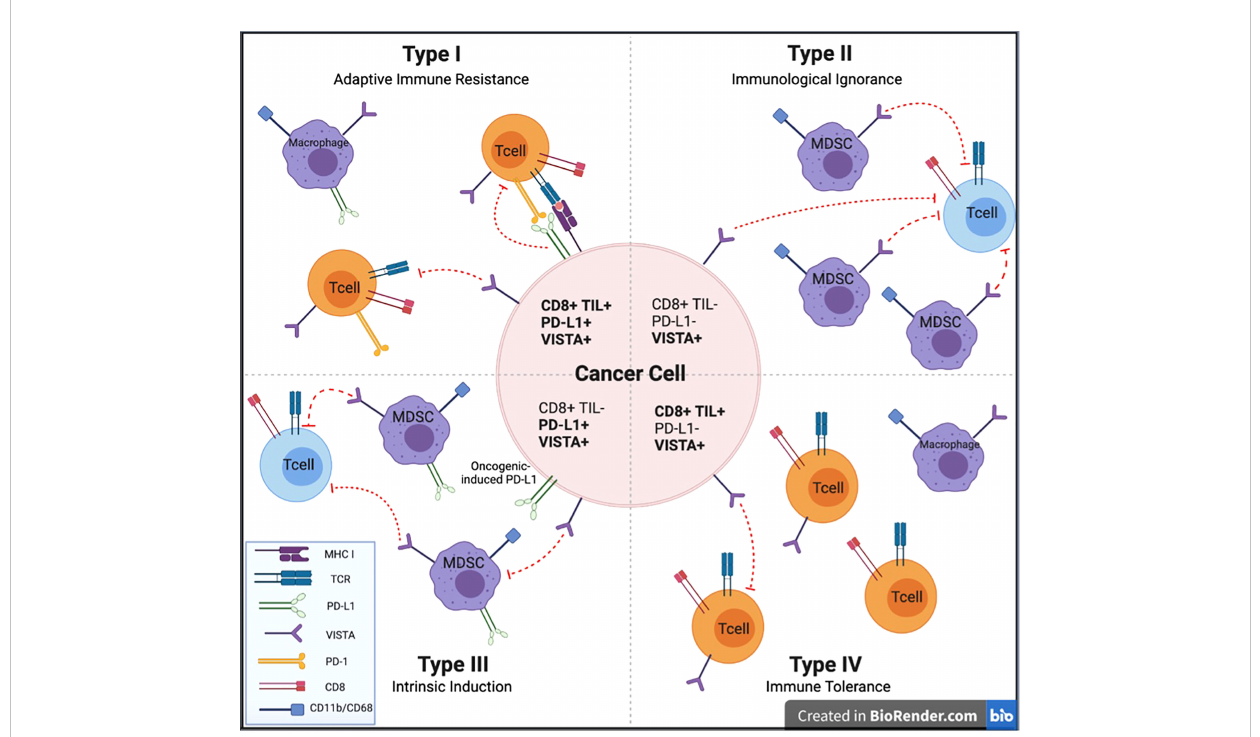
FIGURE 3 Types of tumor microenvironment targets for potential anti-cancer immunotherapies. Cancers are categorized into 4 different tumor microenvironments based on the presence or absence of CD8+ TILs and PD-L1 expression. We describe the potential impact of VISTA expression to each of these TME categories to facilitate investigation of anti-VISTA agents to improve upon immunotherapeutic strategies for each of these TME types. CD, Cluster of Differentiation; MDSC, myeloid derived suppressor cell; MHC I, major histocompatibility complex class I; PD-L1, programmed cell death ligand 1; PD-1, programmed cell death protein 1; TCR, T cell receptor; TIL, tumor-in fi ltrating lymphocyte; VISTA, V-domain Ig suppressor of T-cell